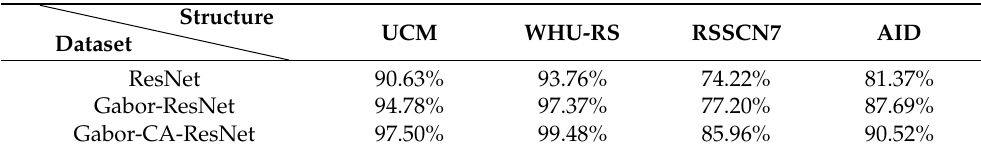
Table 1. Performance comparison of mean Average Precision (mAP) with different network struc- tures.